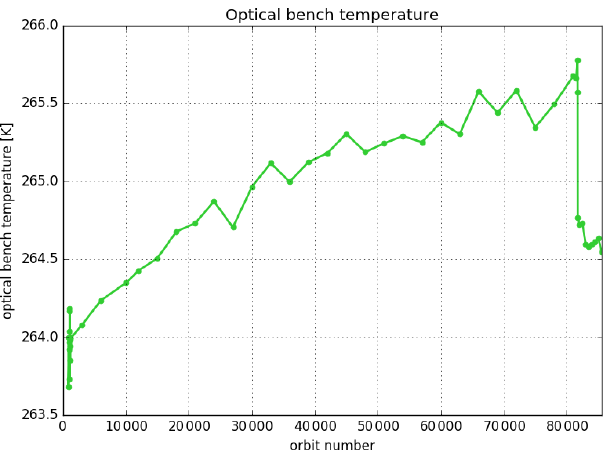
Figure 15. Observed wavelength shift in the UV1 channel for all orbits included in this analysis versus temperature as black dots. The dense group on the left is obtained during the nominal opera- tion phase, whereas the two sparse groups on the right are measured early in the mission during the commissioning phase when the in- strument was operated at higher temperatures. The maximum shift of 140pm corresponds to a shift of 0.42 detector pixels in